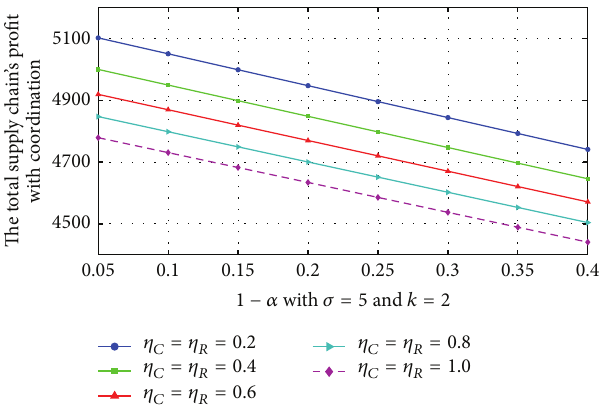
Figure 3: Impact of changes of 1−𝛼 on the total supply chain’s profit with coordination in different 𝜂 𝑅 .